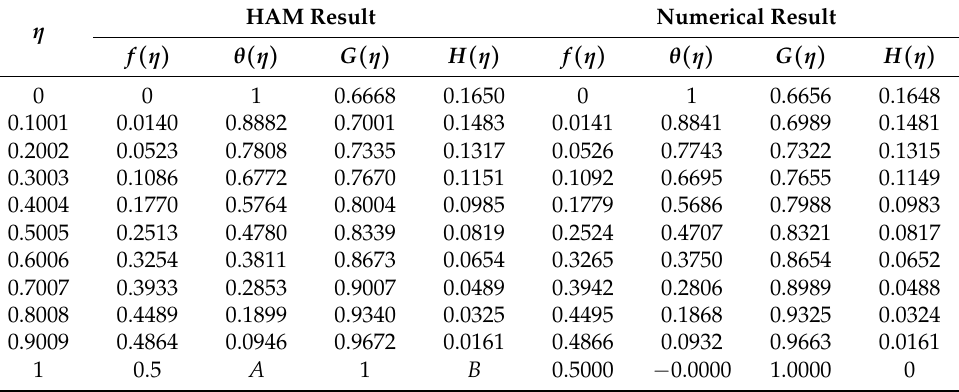
Table 3. Computations for f ( η ) , θ ( η ) , H ( η ) and G ( η ) when S = − 2, Pr = R = Sc = K 1 = K 2 = Ha = 0.5, L = δ = 2, Q = 4 and various values of η . Furthermore, A = 6.57027 × 10 − 17 and B = − 4.0827 × 10 − 19